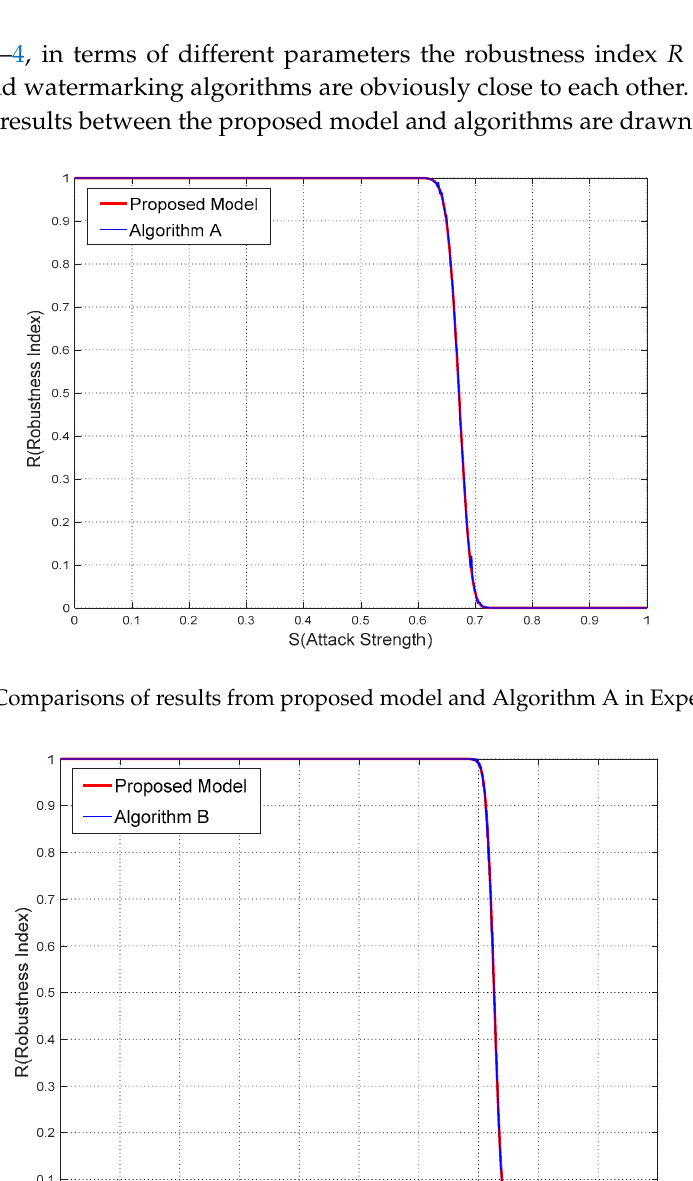
Table 4. Part of robustness results in Experiment 3.